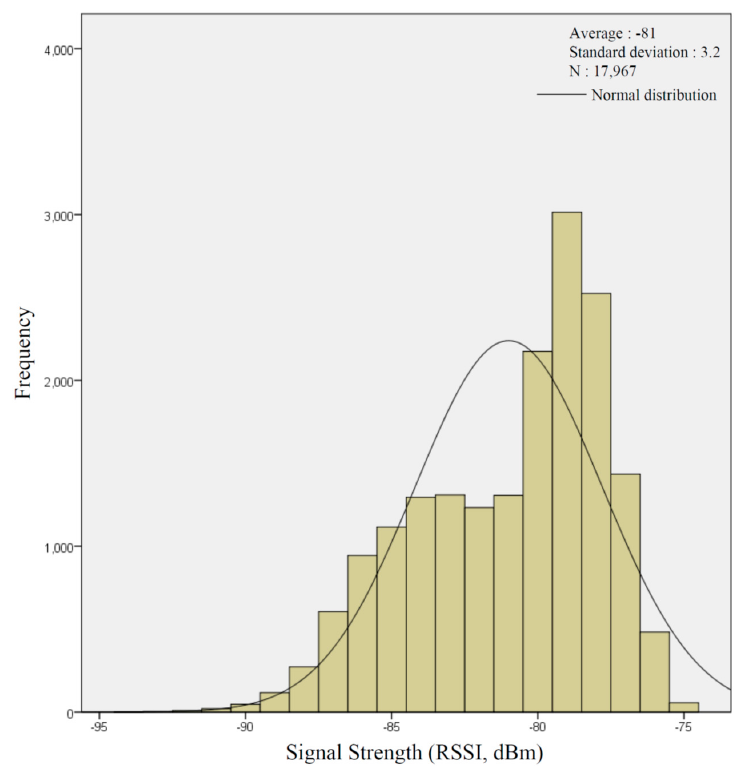
Figure A1. Histogram of the frequency of total signal strength.